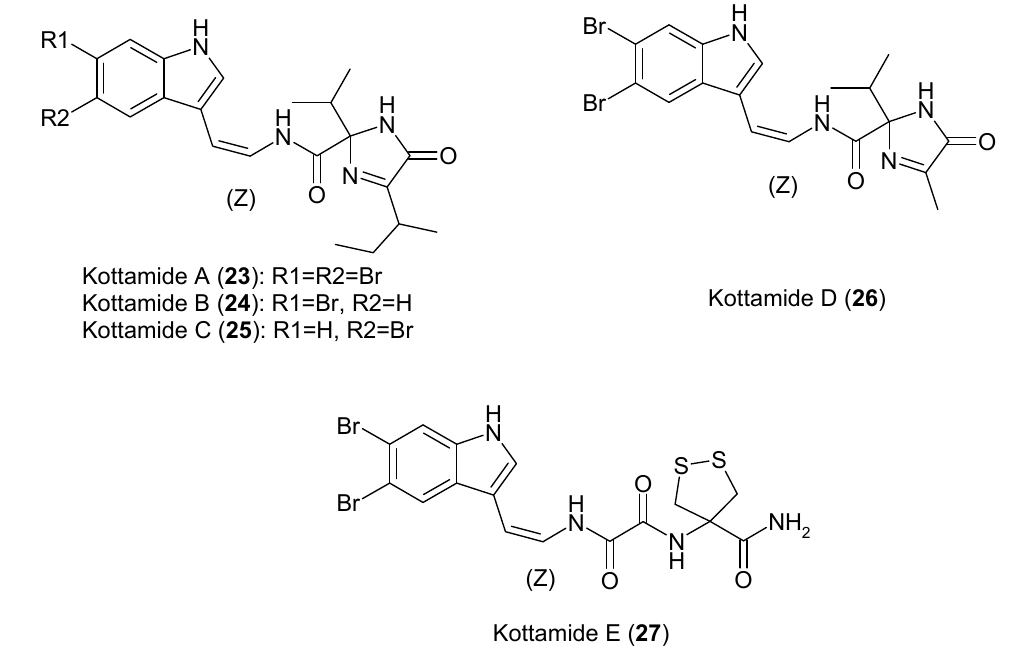
Figure 6. Kottamide structures isolated from Pycnoclavella kottae